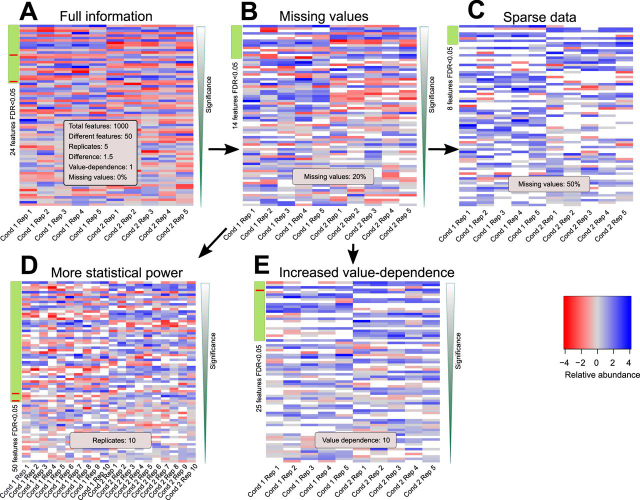
Performance of Miss test for different artificial data sets with missing values.A–E, Most significantly changing features according to Miss test for differently parametrized artificial data sets. True and false positives are indicated by green and red sidebar values, respectively.